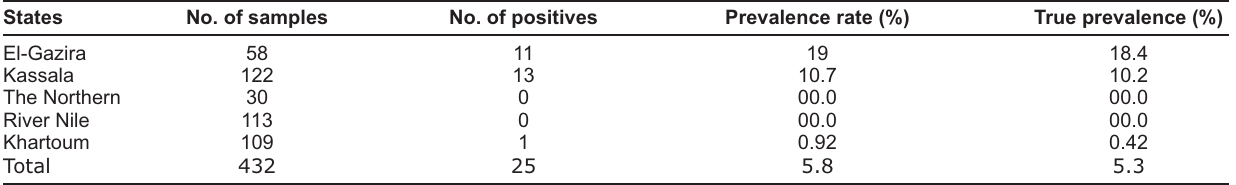
Table-1. Seropositivity to CAEV antibodies in goats detected by cELISA from different states in Sudan States No. of samples